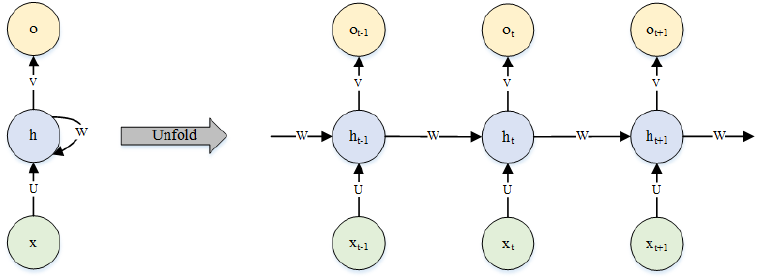
Figure 1. The structure of a simple